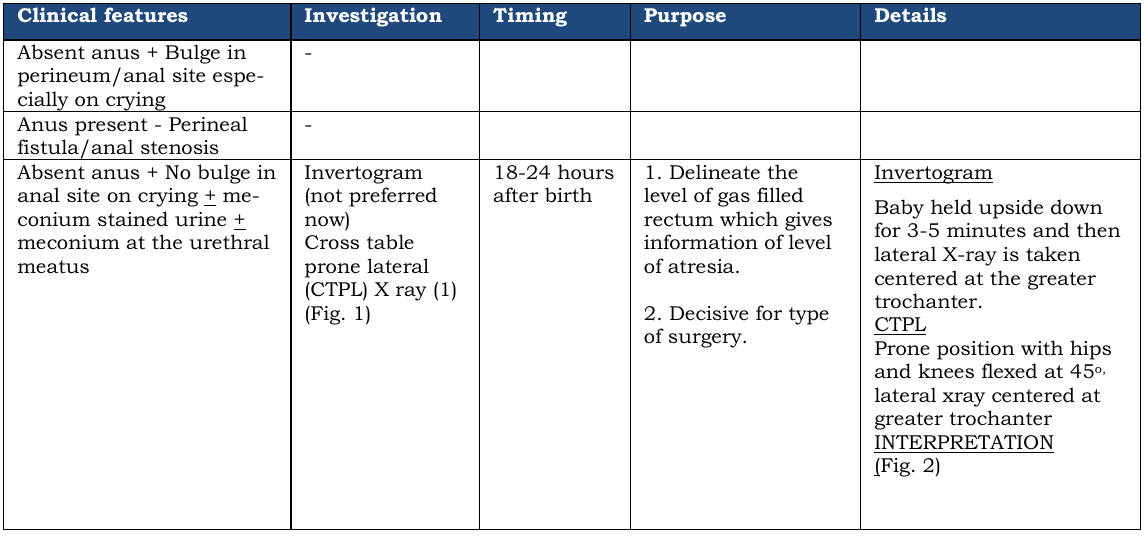
Table 1: Investigations for boys with anorectal anomalies